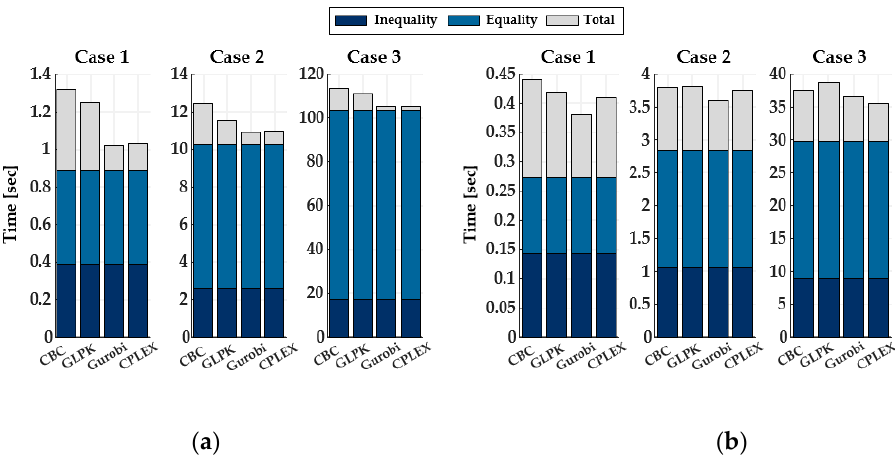
Figure 11. Total computation times. ( a ) first scheduling stage; ( b ) second scheduling stage.